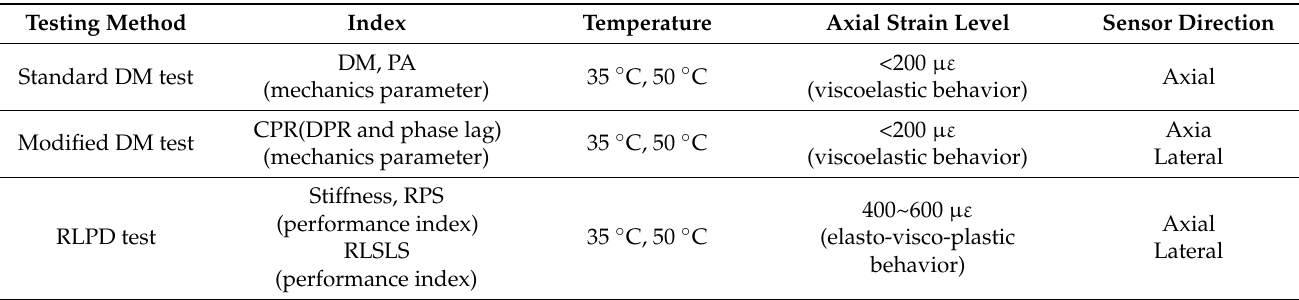
Table 5. The details of the analyzed indices of different testing